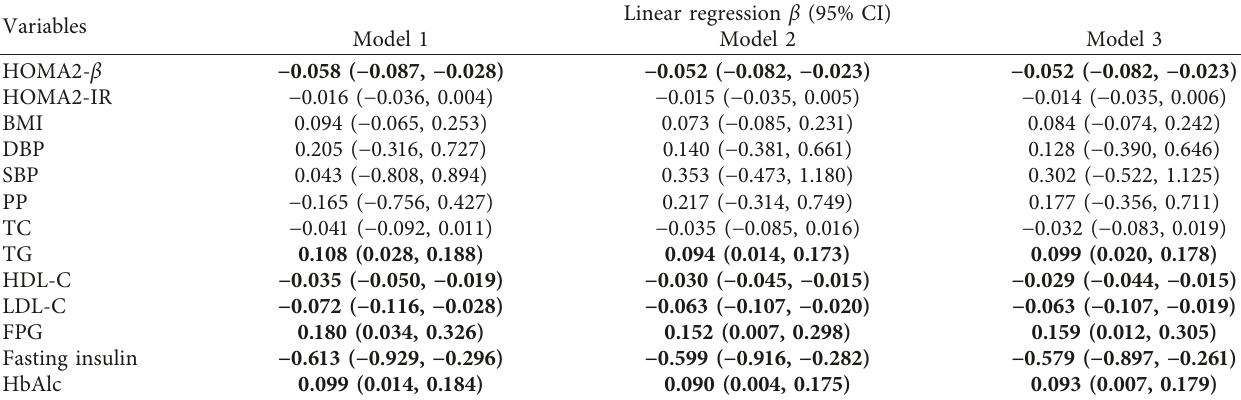
Table 3: Linear regression analysis of associations between cortisol and multiple cardiovascular risk factors.